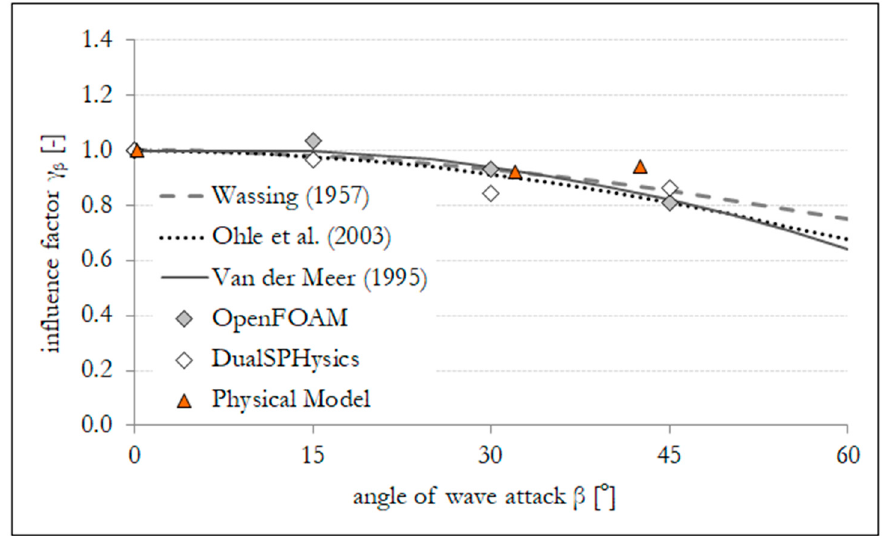
Figure 8. Influence factor γ β for oblique, regular wave attack from numerical simulations and the literature.